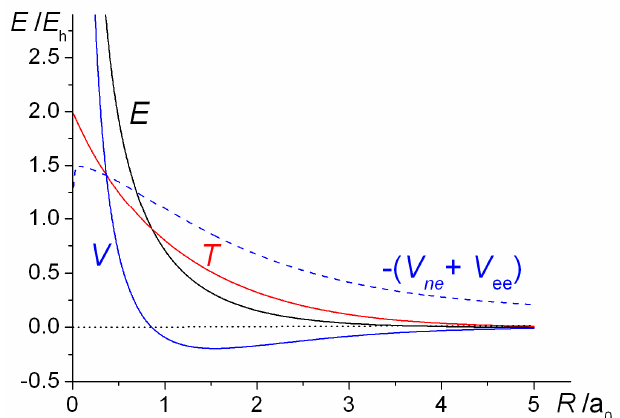
Figure 16. The triplet ( 3 Σ g ) state of H 2 . The total energy ( E ), and its kinetic ( T ) and potential ( V ) components (relative to the energies of two H atoms), are shown in black, red, and blue, respectively. The blue dashed line corresponds to the magnitude of the electronic component of V . The energies were computed in the minimal basis of hydrogenic 1s AOs with a fixed exponent of